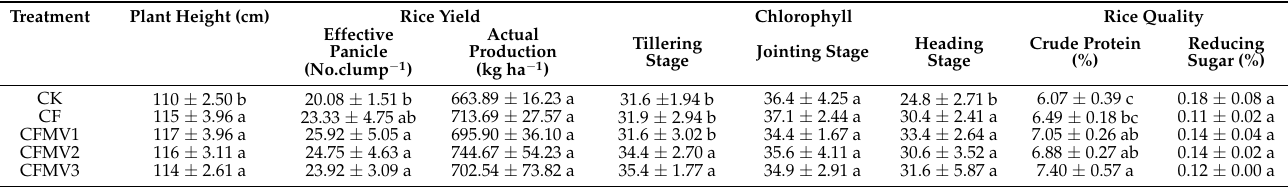
Table 3. Rice plant characters and rice quality